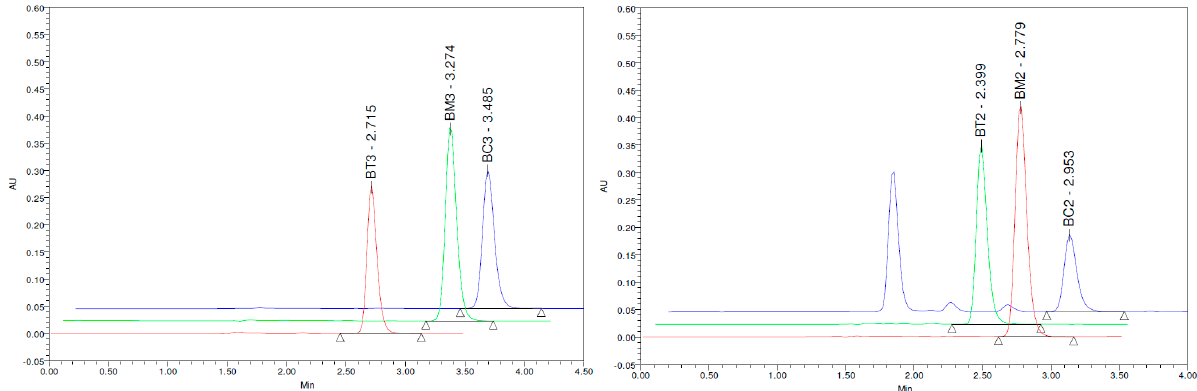
Figure 3. Representative chromatograms of standard samples containing 10 µg/mL of each tested